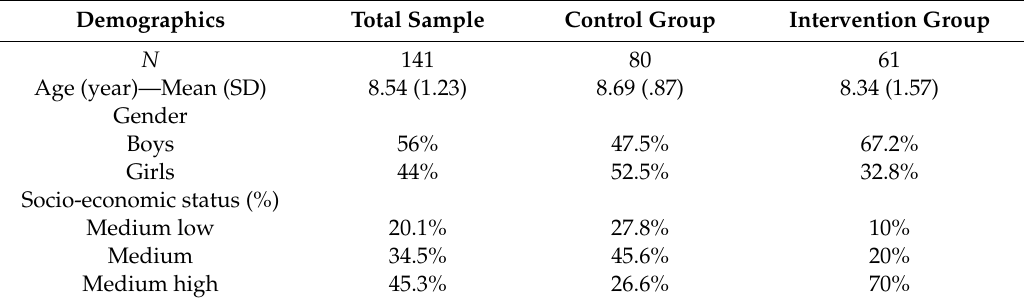
Table 1. Demographic information for the total sample, the control group (CG), and the intervention group